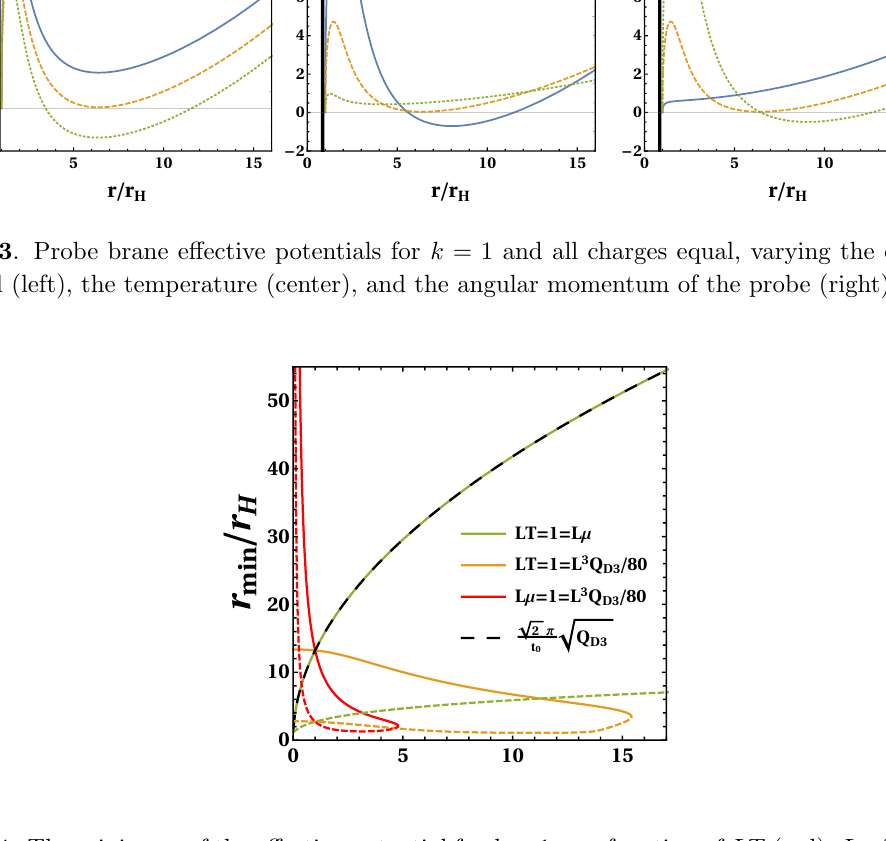
Figure 4 . The minimum of the e(cid:11)ective potential for k = 1 as a function of LT (red), L(cid:22) (orange), and L 3 Q D3 = 80 (green), when the other two values are kept (cid:12)xed to unity. The solid parts of the curves correspond to minima of the e(cid:11)ective potential, whereas dashed ones are the maxima. In all the cases the minimum radial coordinate is at a (cid:12)nite distance away from the horizon as there is always a potential barrier for the brane nucleation. Notice also that we have included the analytic result (4.14) in the limit of large Q D3 as the dashed black